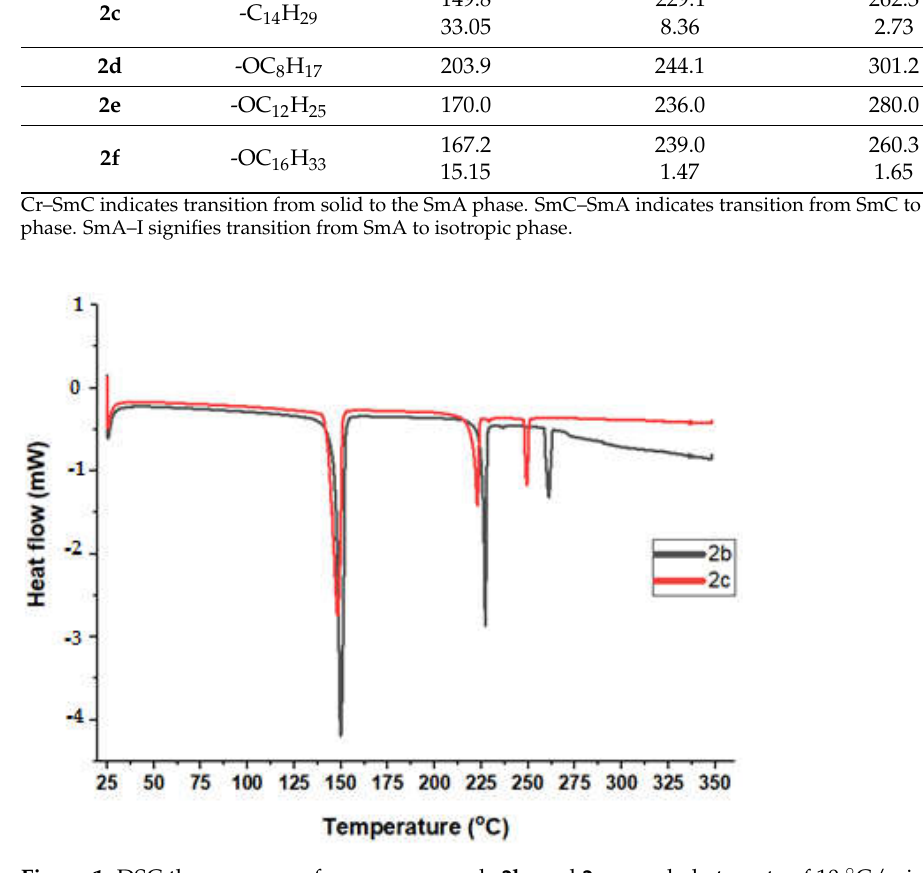
Figure 1. DSC thermogram of new compounds 2b , and 2c recorded at a rate of 10 °C/min during heating cycle.